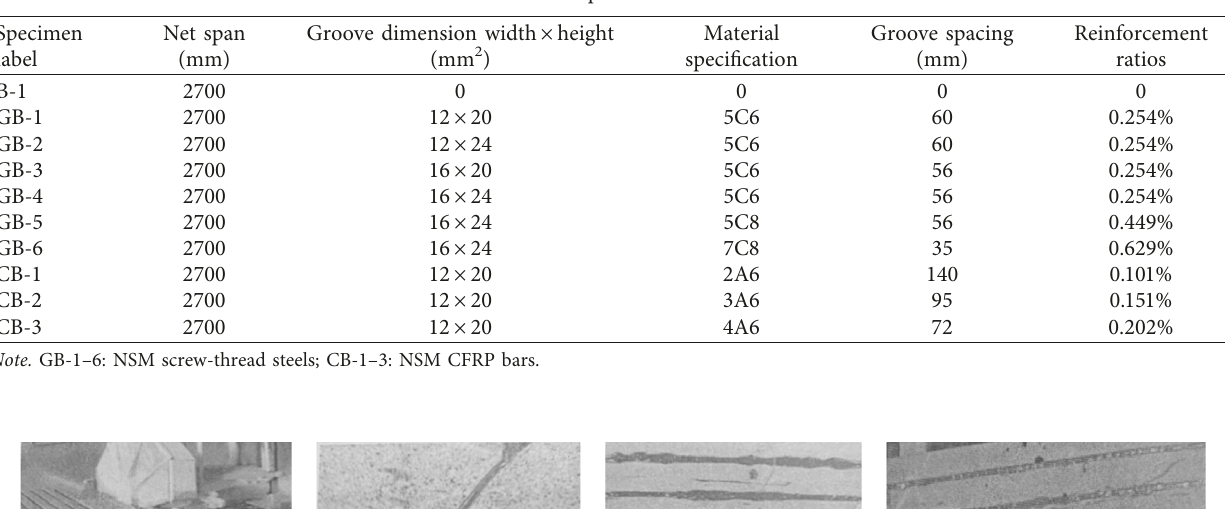
Table 7: Specimen details.